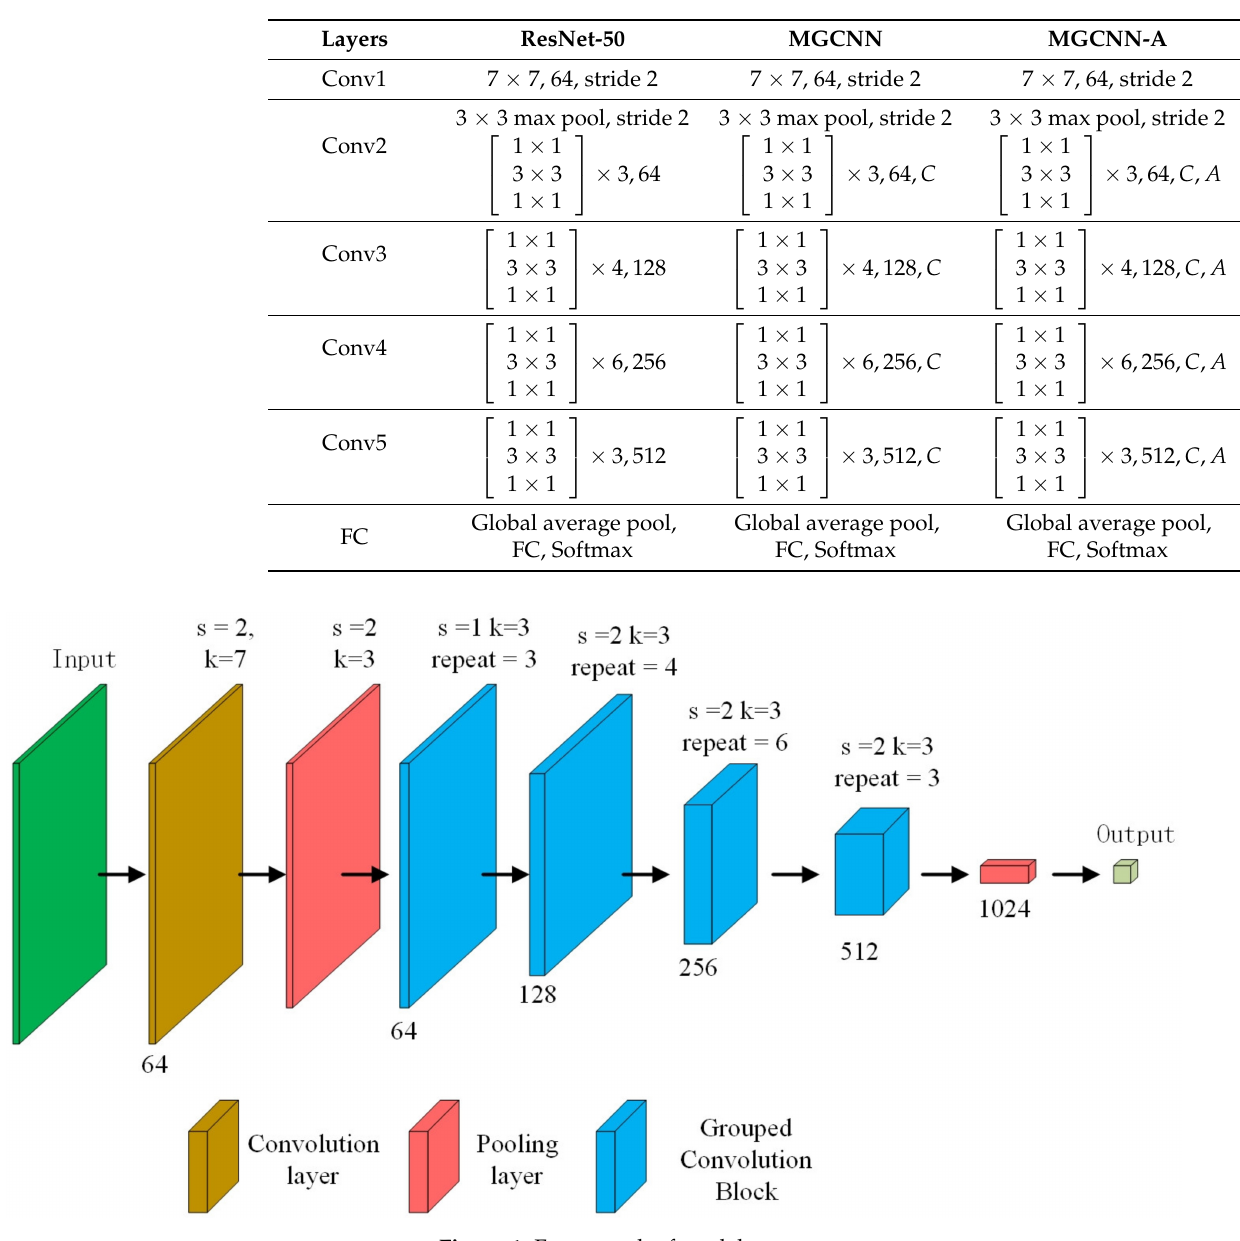
Figure 1. Framework of